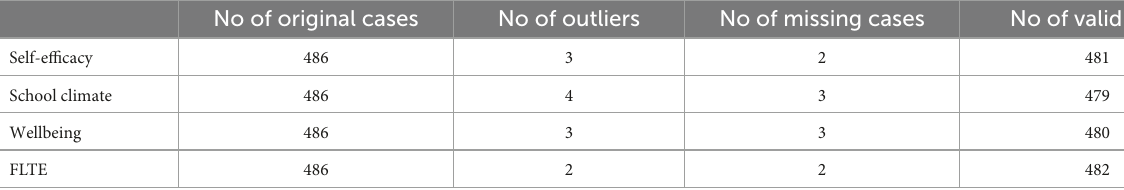
TABLE 1 Number of cases for each measure.